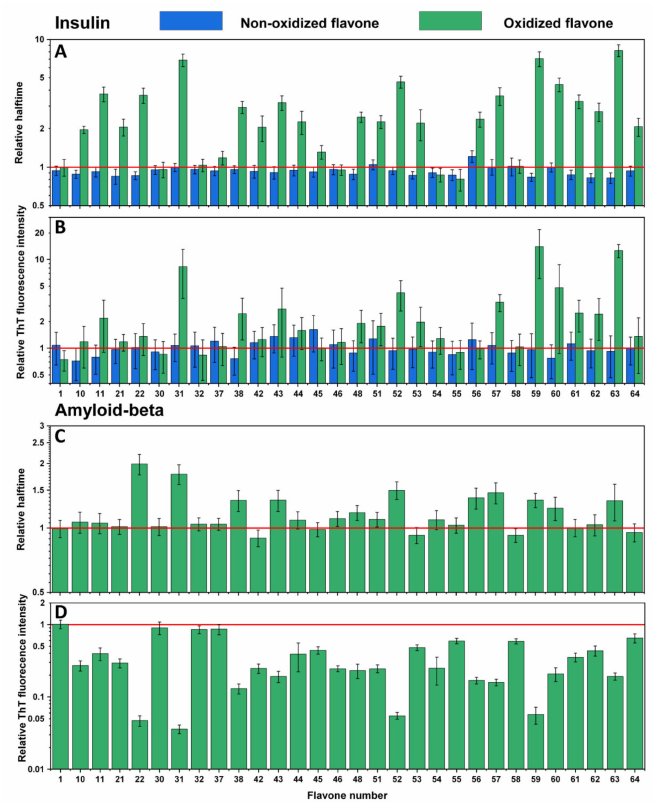
Figure 2. Effects of non-oxidized and oxidized flavones on insulin aggregation kinetics ( A ) and relative ThT fluorescence intensity ( B) . Effect of oxidized flavones on A β 42 aggregation kinetics ( C ) and relative ThT fluorescence intensity ( D ). Error bars are for one standard deviation ( n = 4). None of the non-oxidized flavones, except 56, inhibited insulin aggregation; after the oxidation, more than half of the flavones showed an inhibitory effect, with 31, 59, and 63 having the most significant impact. Oxidized flavones 22, 31, 52, and 59 increased the relative halftime of A β 42 the most, while 1, 30, 32, 37 did not affect the relative halftime nor the relative ThT fluorescence